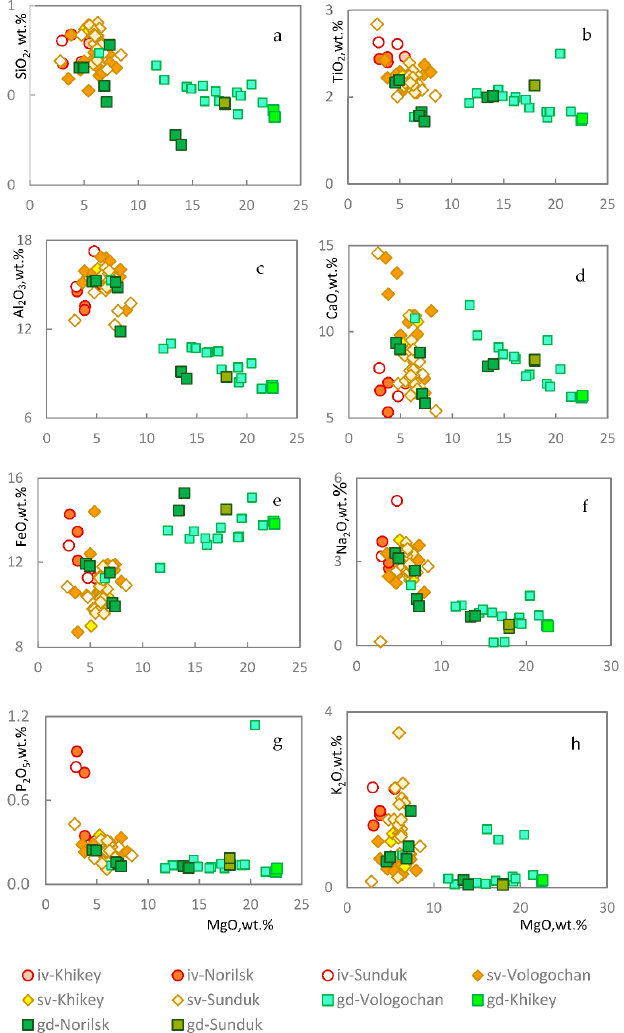
Figure 8. Diagrams MgO vs. SiO 2 ( a ), TiO 2 ( b ), Al 2 O 3 ( c ), CaO ( d ), FeO ( e ), Na 2 O ( f ), P 2 O 5 ( g ), and K 2 O ( h ) for the Ivakinsky, Syverminsky, and Gudchikhinsky Formations.